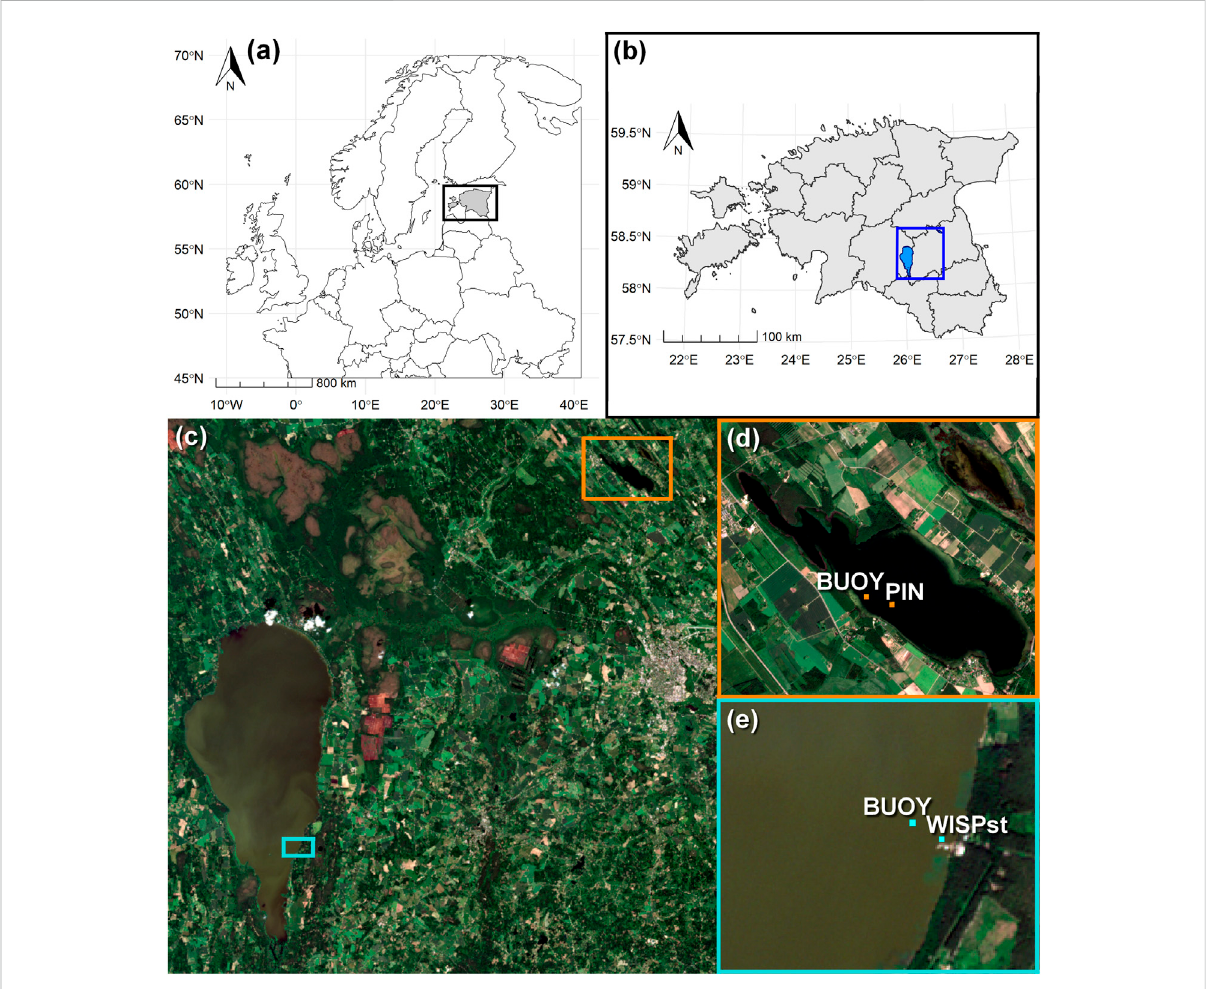
FIGURE 1 Location of the studied lakes on European scale (A) and within Estonia (B) . The location of AHFM buoy and pin location for the satellite data in Saadjärv are in the image with orange frame (C,D) . The location of WISPStation and AHFM buoy in Võrtsjärv are in light blue frame (C,E) . Estonian contour was obtained from the Estonian Land Board